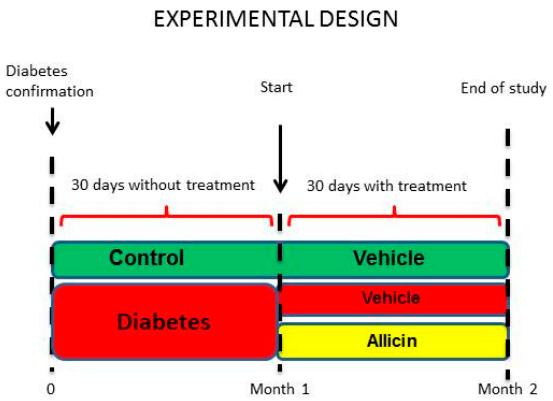
Figure 8. Schematics of experimental design. To examine the effects of allicin on inflammation, we used an experimental model of diabetes. For diabetes induction, streptozotocin (50 mg/kg) was administered intraperitoneally to Wistar male rats. After diabetes confirmation, the rats were maintained for 1 month with food and water ad libitum . One month after diabetes confirmation, the blood glucose levels were measured, and the diabetic rats were subdivided into diabetic or allicin-treated diabetic groups. Once the three experimental groups were formed (control, diabetic and allicin-treated diabetic), the administration of the treatments started daily for 1 month.